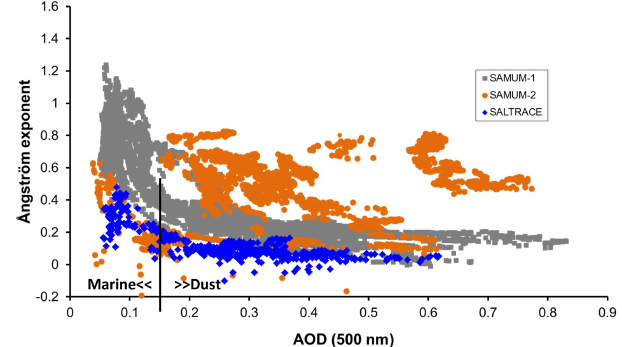
Figure 3. Scatter plot of the Ångström exponent vs. aerosol opti- cal depth (500nm) for SALTRACE as well as the SAMUM-1 and SAMUM-2